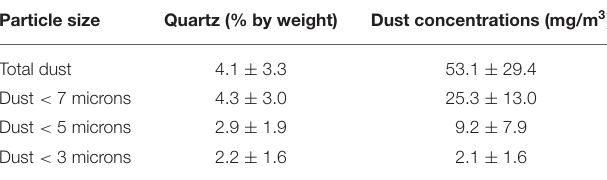
TABLE 5 | Mean quartz content in dust in German coal mines.